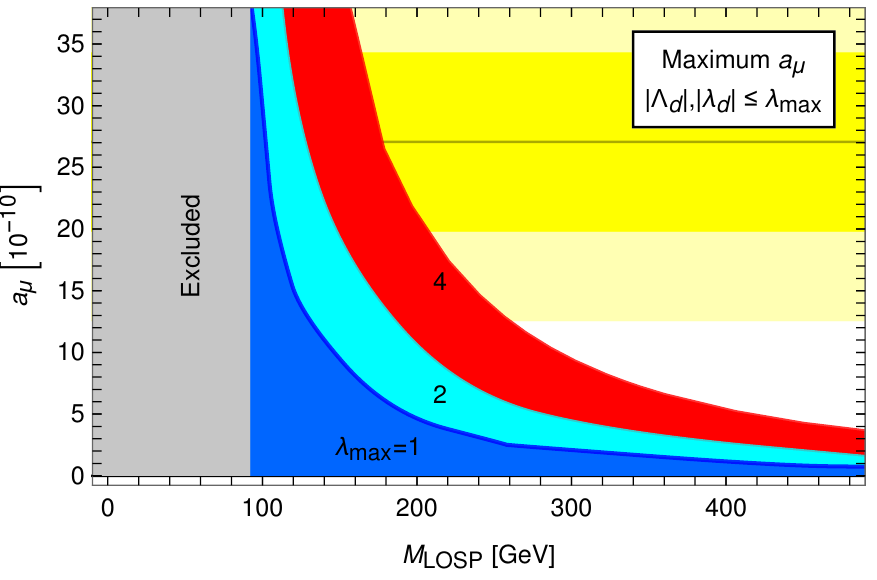
Figure 12. Maximum possible results for a (cid:22) in the MRSSM obtained from a parameter scan applying the constraints of section 4.1 and maximum values for (cid:3) d , (cid:21) d as indicated in the plot. The dark and light yellow horizontal bands correspond to the 1 (cid:27) and 2 (cid:27) bands given by eq. (3.3). The vertical band corresponds to the exclusion limit (4.8).